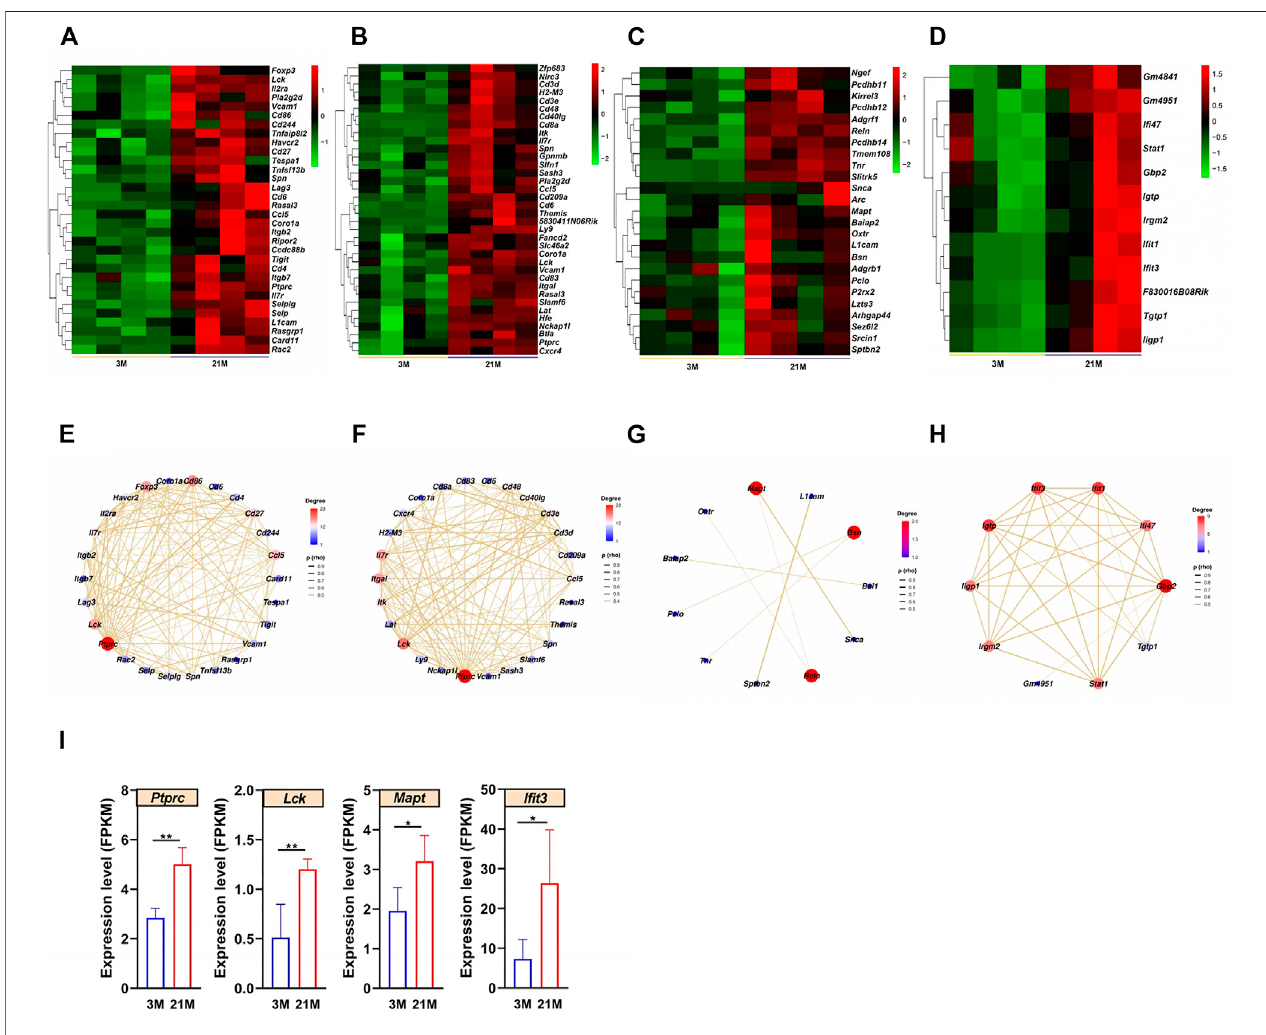
FIGURE 6 | Analysis of aging characteristics in the epididymis. (A – D) Heatmaps of upregulated differentially expressed genes (DEGs) enriched to the most signi fi cant Gene Ontology (GO) terms in the (A) initial segment, (B) caput, (C) corpus, and (D) cauda. (E – H ) Protein – protein interaction (PPI) networks based on the upregulatedDEGsandsigni fi cantGOtermsinfourregionsoftheepididymis. (I) Expressionlevelsof Ptprc , Mapt , Lck ,andI fi t3 increasedwithageaccordingtotheqPCR ( n (cid:2) 6). 3 M: 3-months; 21 M: 21-months.